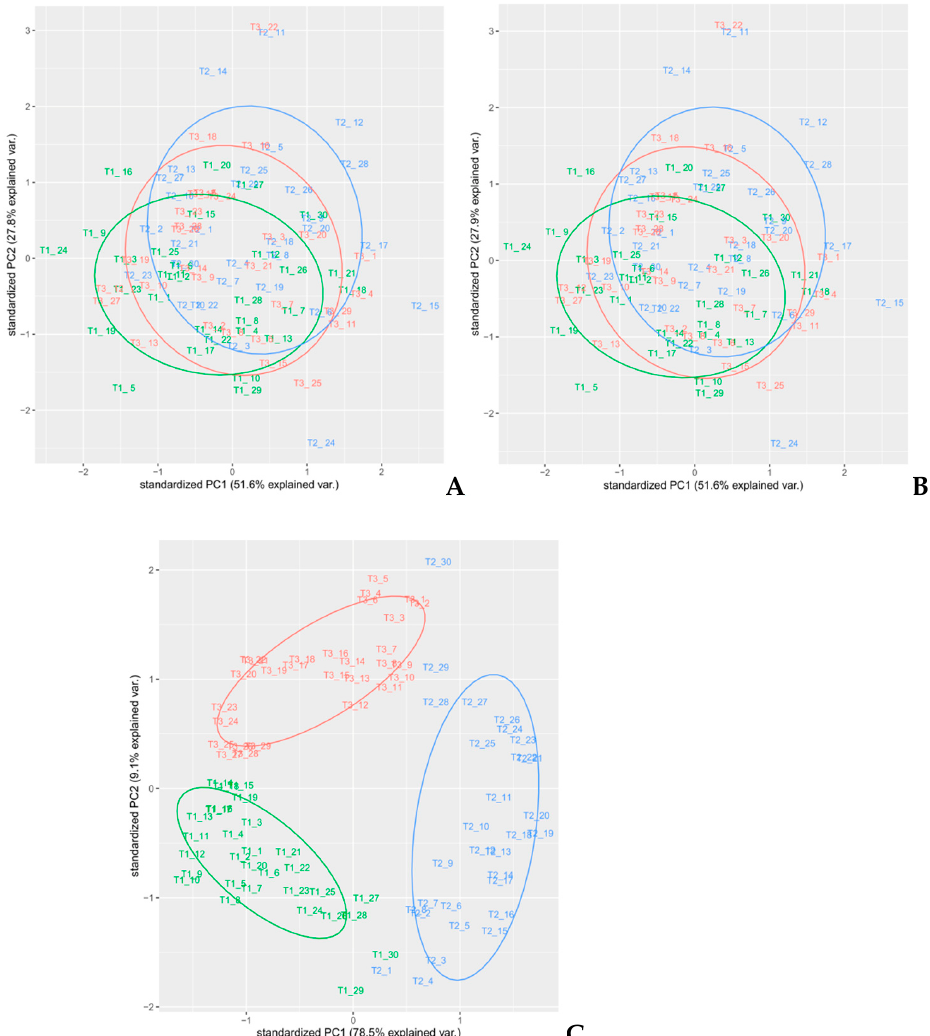
Figure 6. PCA analysis of spectra with different pre-treatments—( A ) MSC, ( B ) SNV, and ( C ) MSC with smoothing.